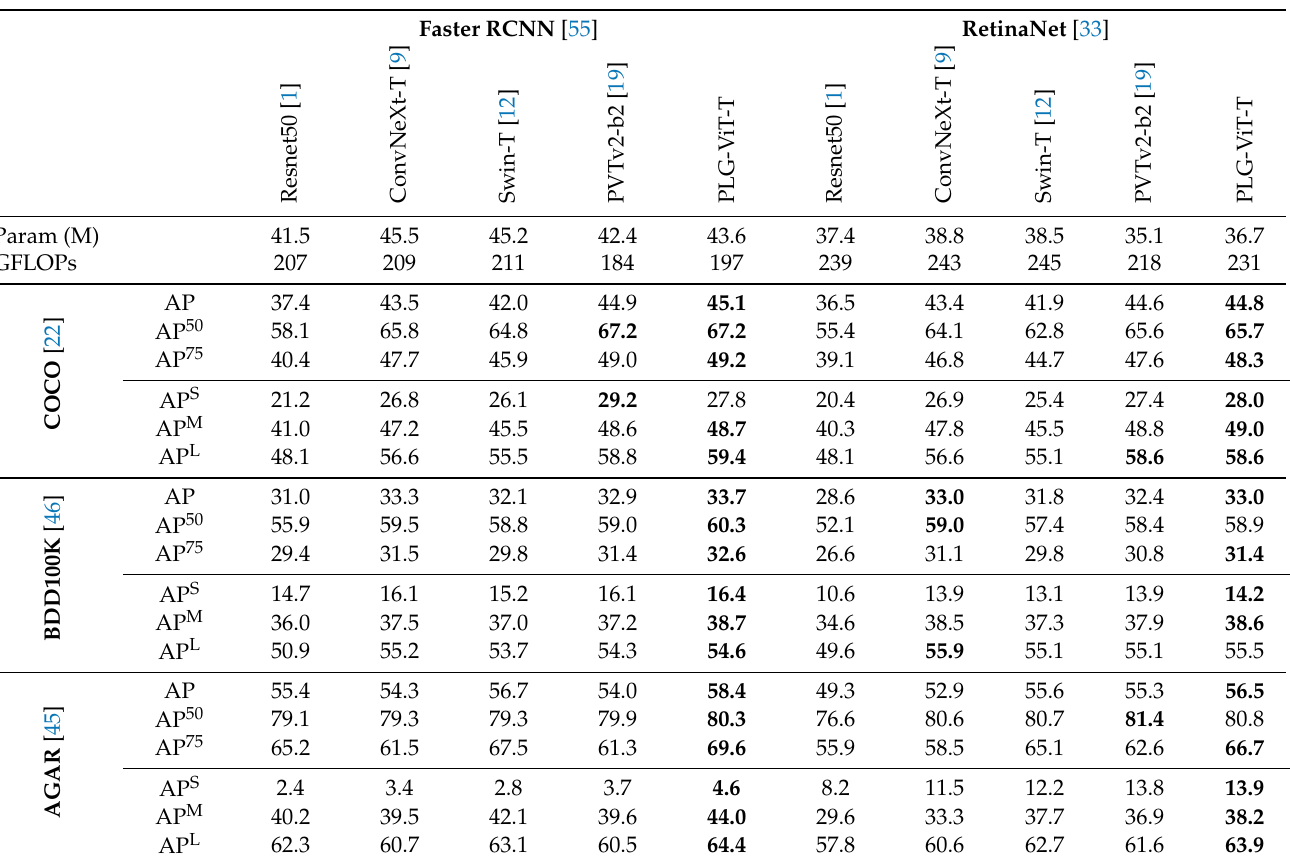
Table 3. Object detection results for 3 vision benchmarks [22,45,46] from diverse domains. Compari- son of our PLG-ViT-T with Swin-T [12], PVTv2-b2 [19], ConvNeXt-t [9], and ResNet50 [1] using Faster RCNN [55] and RetinaNet [33]. FLOPs were calculated with image size (1280, 800). All models were trained with a single-scale input and 1 scheduler and the best results are highlighted in bold . All × values are based on reproduced